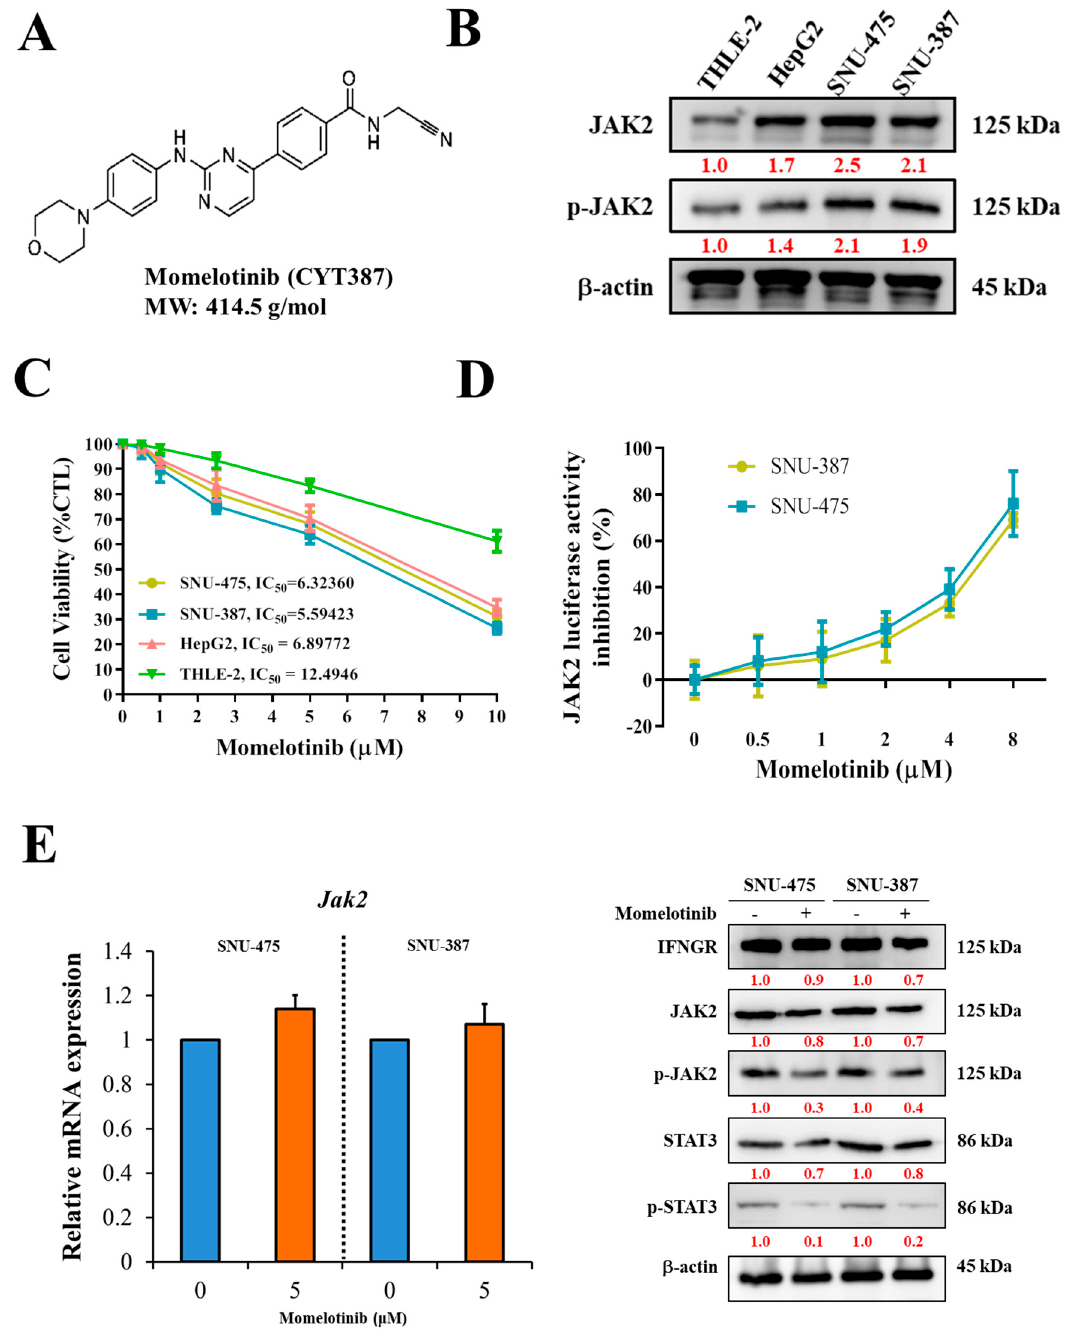
Figure 2. Inhibition of Jak2 by momelotinib. ( A ) Chemical structure of momelotinib (CYT387). ( B ) Immunoblot showing the expression of Jak2 and p-Jak2 in HCC cells. ( C ) Cell viability of SNU-475 and SNU-387 cell lines treated by momelotinib. ( D ) SNU-475 and SNU-387 cells were analyzed using a dual-luciferase assay. Dual-luciferase assays were performed in liver cancer cells after 24-h treatment with momelotinib. ( E ) Relative mRNA and protein expression of Jak2 after momelotinib treatment. Control (without momelotinib) groups were treated with DMSO. The momelotinib treatment dose and time with 5 µM and 48 h. β -actin was used as a loading control.